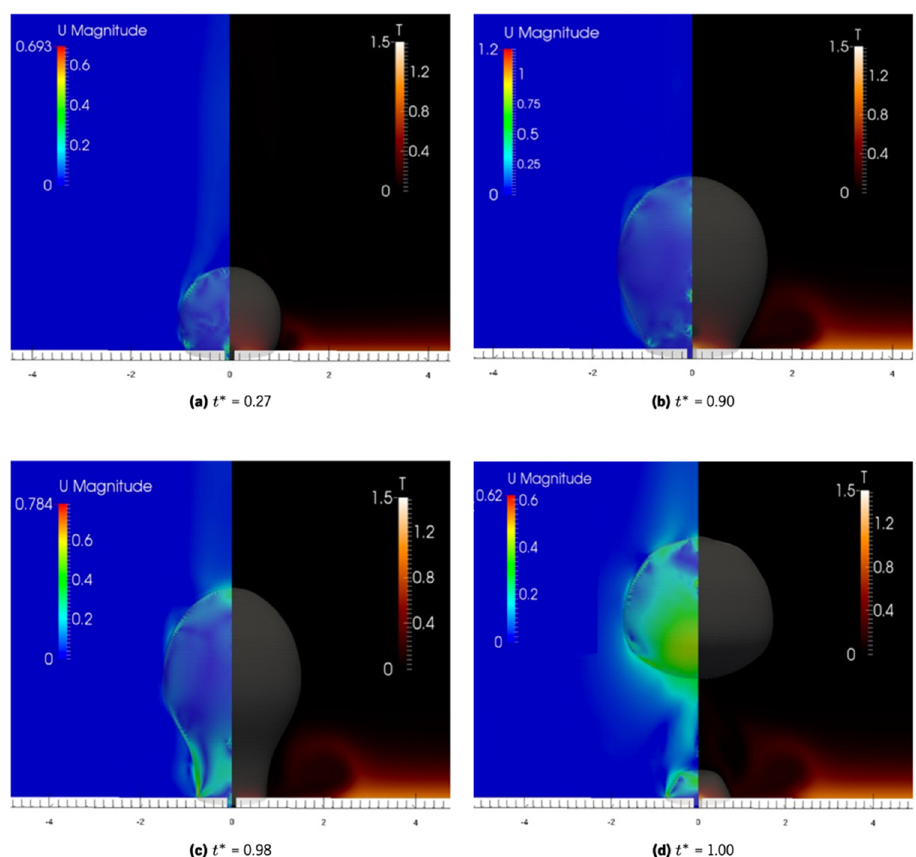
Figure 13. Velocity magnitude and temperature during bubble growth. The imposed heat flux is 1290 W/m 2 , the fluid is water and the superhydrophobic region diameter is 1.5 mm. ( a ) bubble growth at t * = 0.27. ( b ) bubble growth at t * = 0.90. ( c ) bubble necking at t * = 0.98. ( d ) bubble detachment at t * = 1.00.